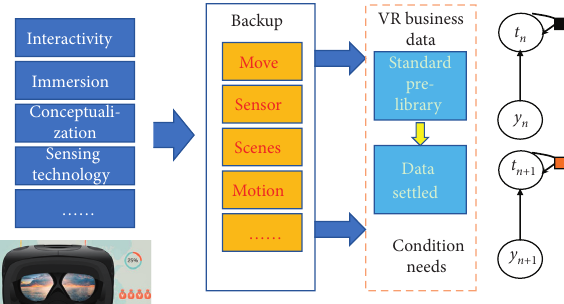
Figure 1: Virtual reality technology scene